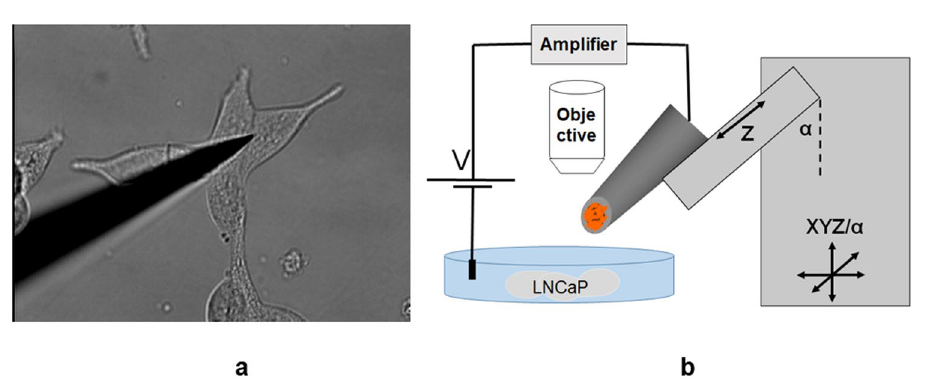
Figure 4. ( a ) Photomicrograph of intracellular measurement of ROS in LNCaP cells by nanoelectrode. ( b ) Schematic diagram showing the intracellular measurement system, key components and the movements in X, Y, and Z directions that could be